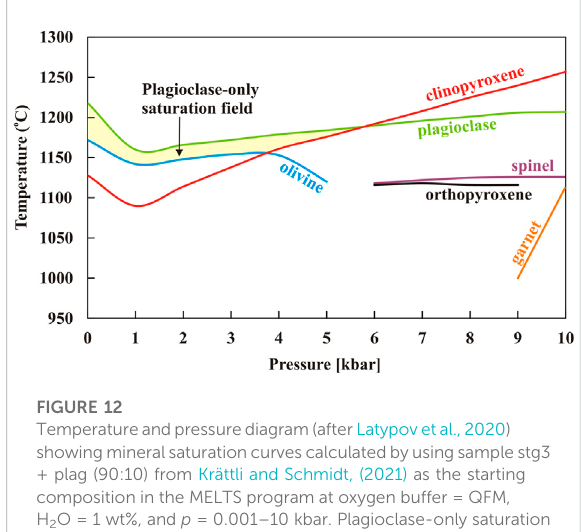
FIGURE 12 Temperatureandpressurediagram(afterLatypovetal.,2020) showingmineralsaturationcurvescalculatedbyusingsamplestg3 + plag (90:10) from Krättli and Schmidt, (2021) as the starting composition in the MELTS program at oxygen buffer =